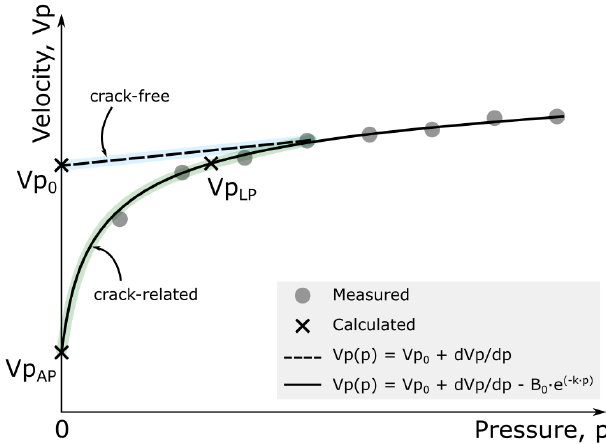
Figure 5. Schematic velocity–pressure relation depicting the mea- sured and calculated seismic P-wave velocity Vp as a function of confining pressure p . Based on the best curve fit for the linear (dashed line) and non-linear part (solid line), velocities can be cal- culated under different environmental conditions: Vp0 – intrinsic velocity, VpAP – atmospheric pressure, VpLP – lithostatic pressure (adapted from Ji et al.,